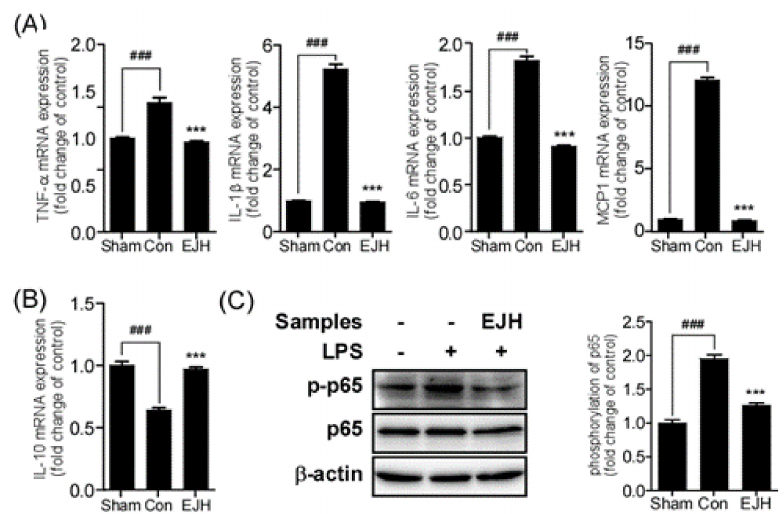
Figure 7. E ff ect of EJE on cytokines and p65 phosphorylation in the hippocampus of LPS-induced depressive mice. LPS-induced changes in cytokine mRNA expression in the hippocampus were significantly recovered by oral administration of EJH ( A ), ( B ) EJH significantly reduced phosphorylation of p65 in the hippocampus ( C ). Results are presented as mean ± SEM. EJE, E. japonicum extract; LPS, lipopolysaccharide; Con, control; EJH, EJE 300 mg / kg. *** p < 0.001 versus the LPS-injected Con; ### p < 0.001 versus the Sham. TNF- α , tumor necrosis factor- α ; IL-1 β , interleukin-1 β ; IL-6, interleukin-6;